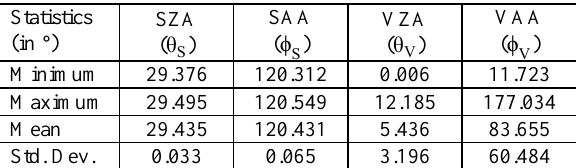
Table 2. Descriptive statistics of the angles for the 1 st HSI cube.